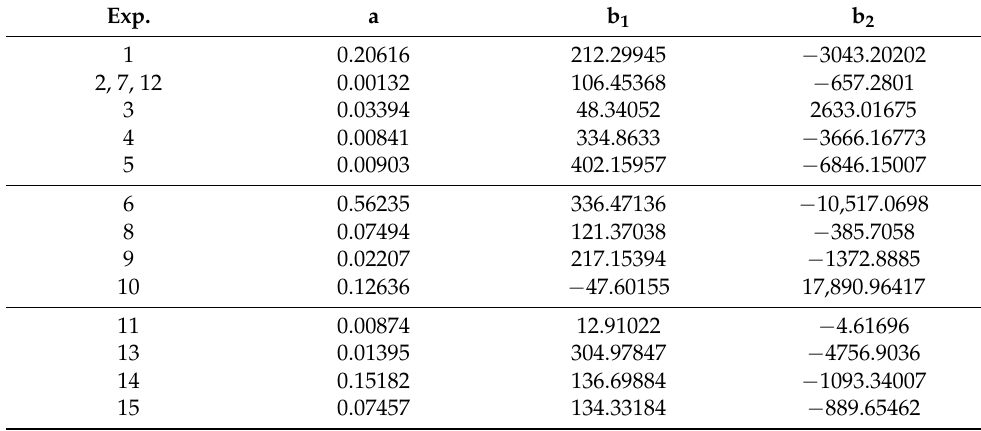
Table 5. The correlation coefficient of the exponential function model for different grid microstructures.